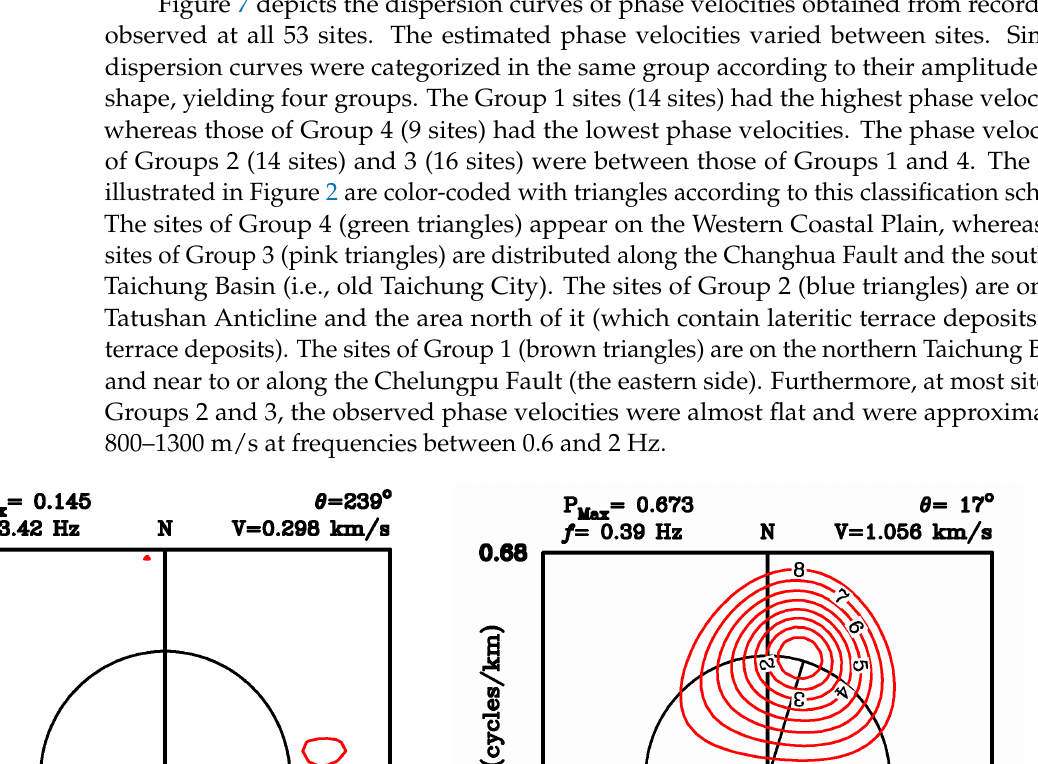
Figure 6. Average and average ± 1 standard deviation of the phase velocities obtain from the record- ings at site DTE. Symbols represent the results from the arrays of different sizes and K values. The black line is the final dispersion curve used in the study.